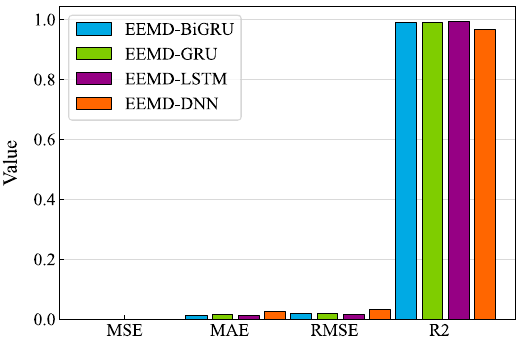
Figure 17. Evaluation metric comparison results for the wind pressure dataset using the EEMD- based algorithms. based